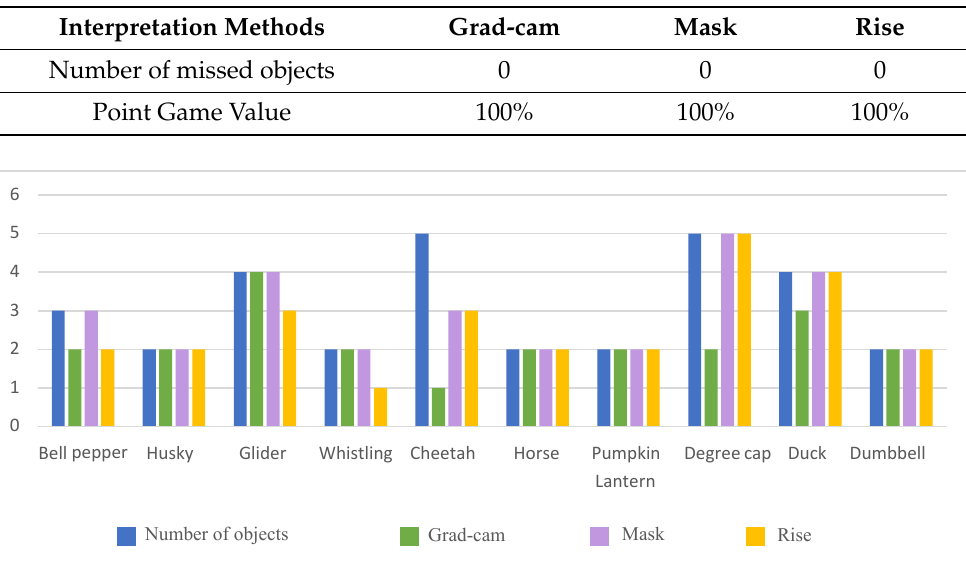
Table 7. Point game statistics of three explanation methods on DataM.